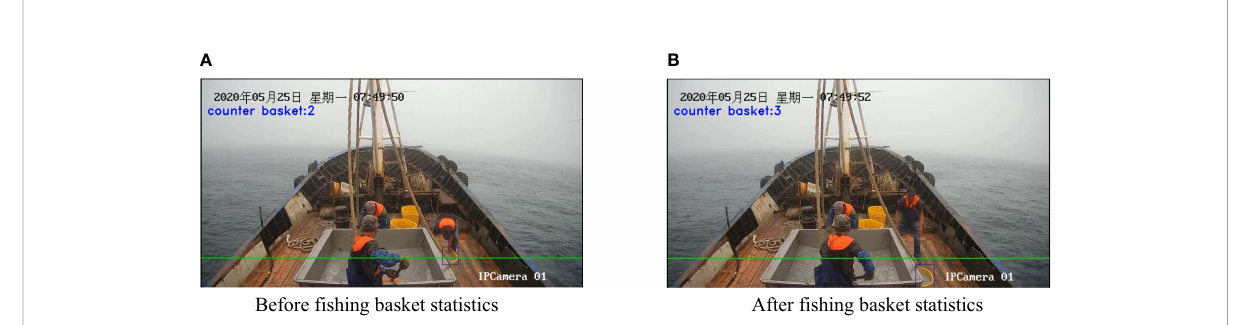
FIGURE 11 Statistics of fi shing baskets.